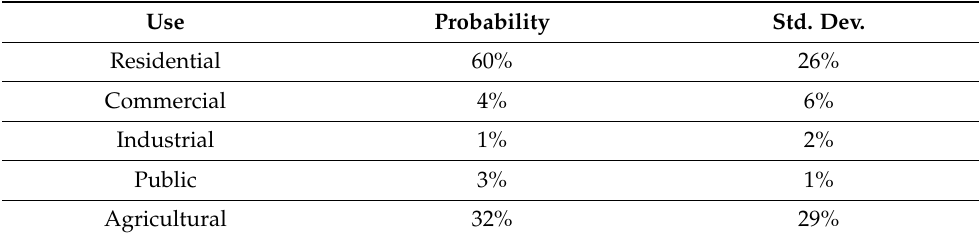
Table 3. Average probabilities of land